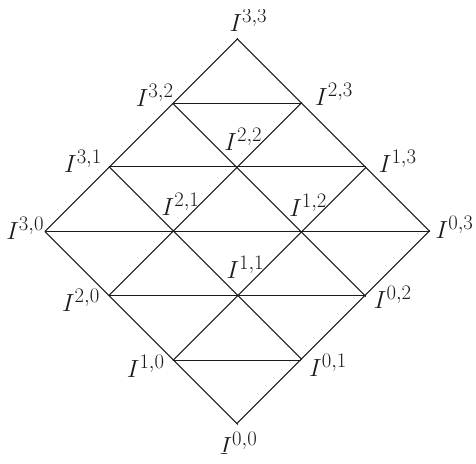
Figure 2 . Limiting Hodge diamond for the middle cohomology H 3 ( CY 3 , C ) of an unspecified CY 3 .